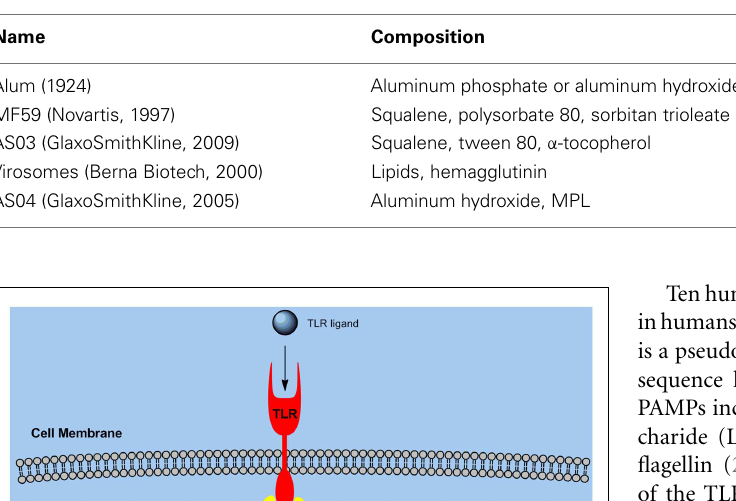
Table 1 |Adjuvants licensed for human use including the year licensed and the propieratory company, composition and use in relevant vaccines (8).